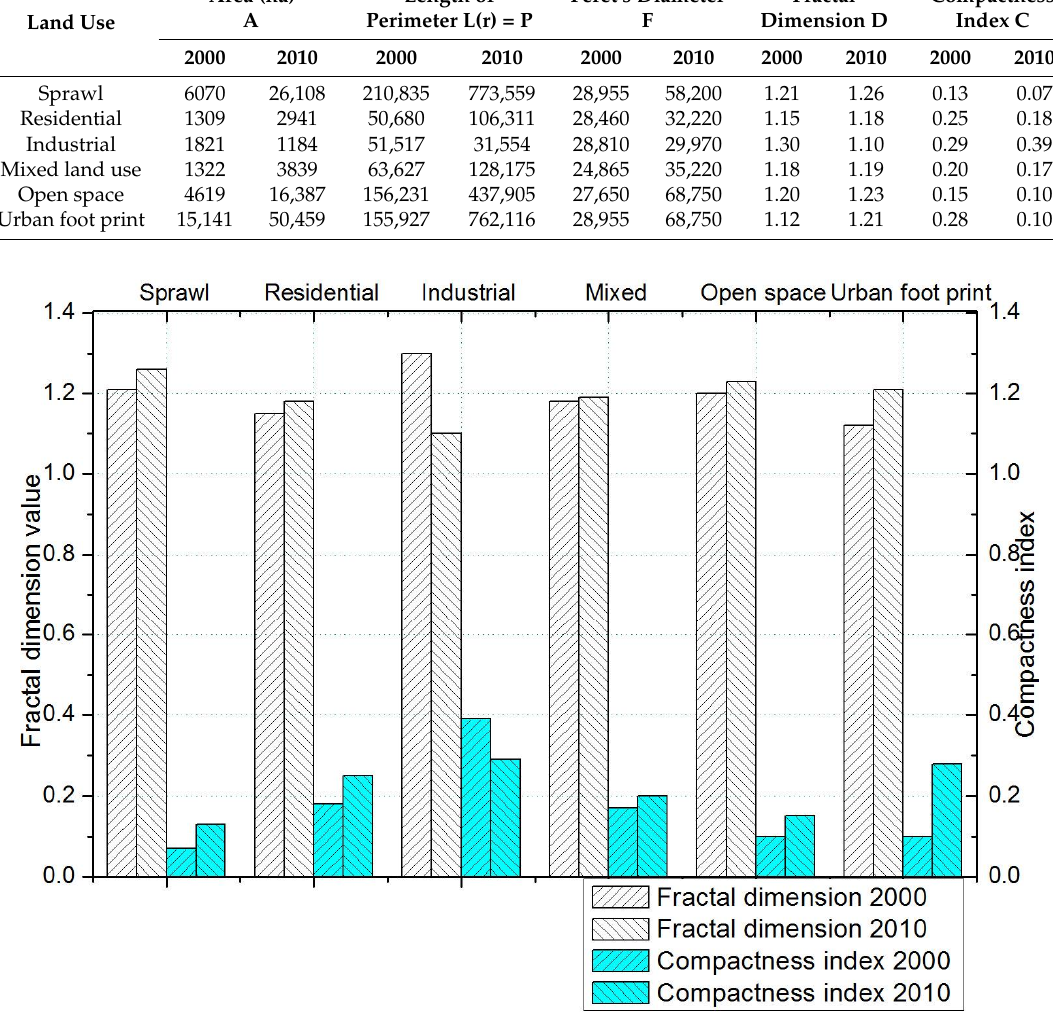
Figure 4. Change of fractal dimensions of urban form and sprawl index for Ulaanbaatar in 2000 and 2010.